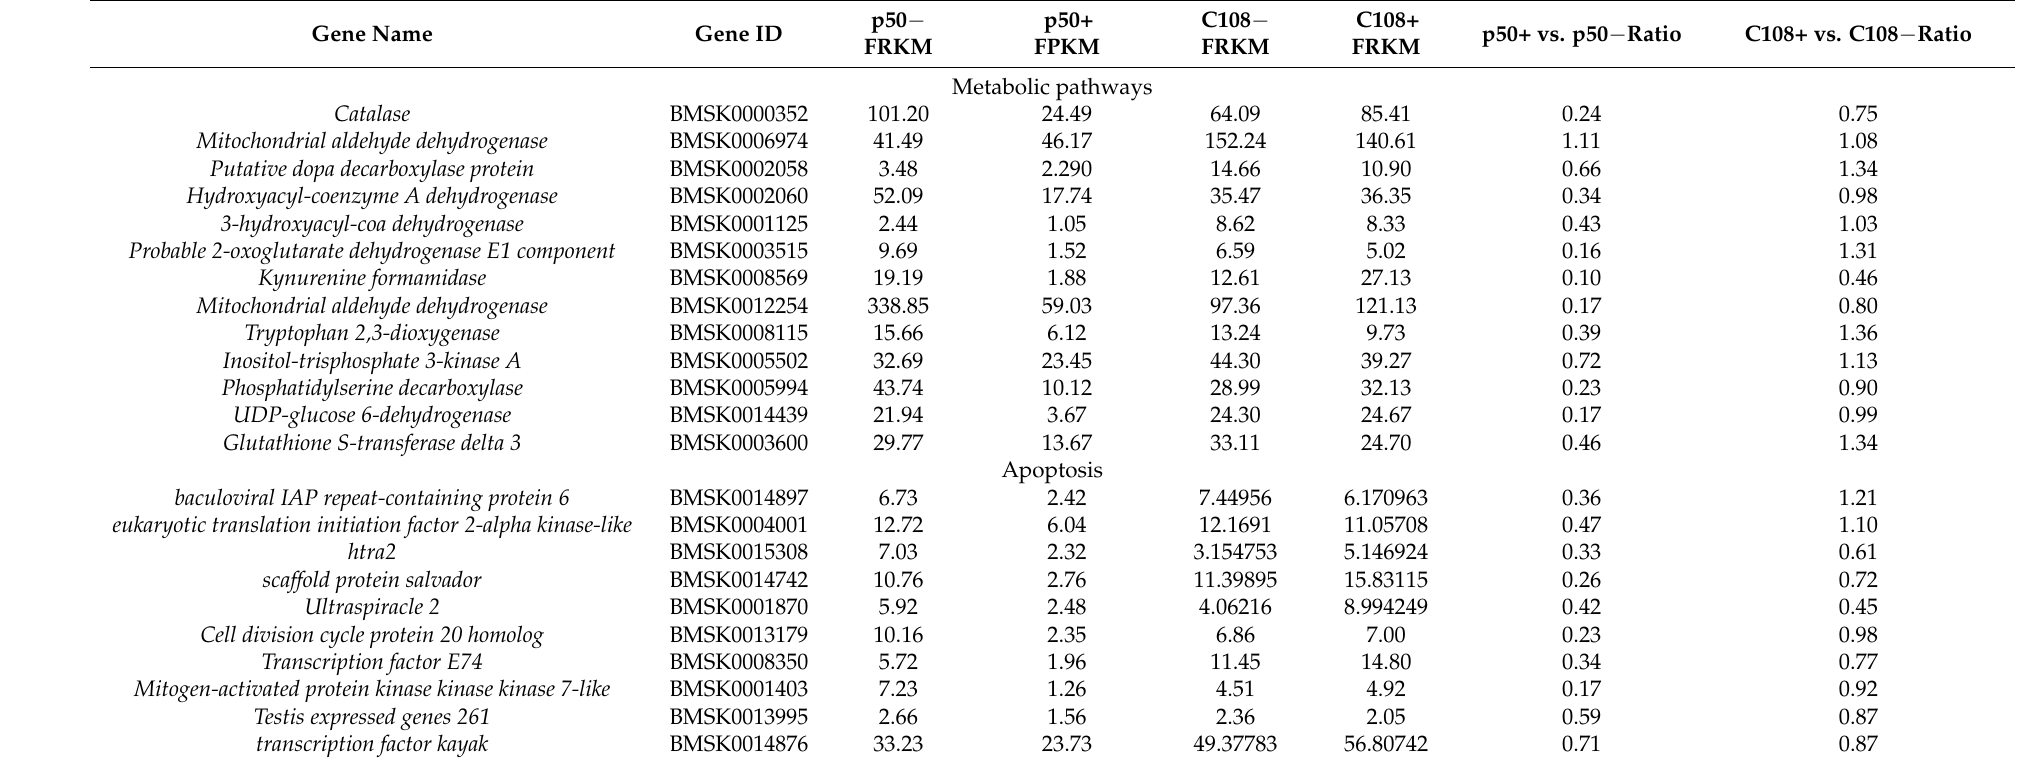
Table 5. DEGs involved in metabolic pathways and apoptosis